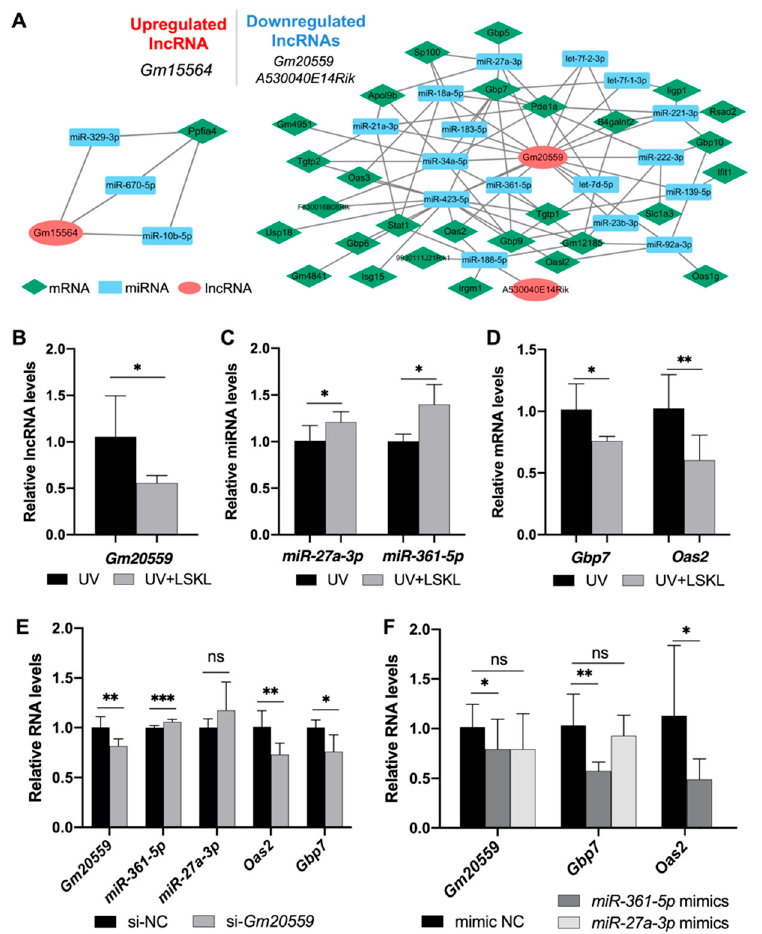
Figure 4. Construction and stepwise validation of a ceRNA network. ( A ) Up- and downregulated coexpression networks of DE-lncRNAs, DE-mRNAs and predicted target miRNAs. Red ovals, green triangles and blue rectangles represent lncRNAs, mRNAs, and miRNAs, respectively. The lines represent correlations. ( B ) RT ‒ qPCR analysis of Gm20559 in UV/Ctrl and UV/LSKL 661W cells. Gm20559 was downregulated in UV/LSKL 661W cells compared with UV/ctrl. ( C ) miR-27a-3p and miR-361-5p were upregulated in UV/LSKL 661W cells compared to UV/ctrl. ( D ) Oas2 and Gbp7 were downregulated in UV/LSKL 661W cells compared to UV/ctrl. ( E ) 661W cells were transfected with si- Gm20559 or si-NC for 48 h and exposed to UV radiation. The expression levels of Gm20559 , miR- 361-5p , miR-27a-3p , Oas2 and Gbp7 were then detected by RT ‒ qPCR. ( F ) 661W cells were transfected with miR-361-5p mimics, miR-27a-3p or NC mimics for 48 h and exposed to UV radiation. Afterward, the expression levels of Gm20559 , Oas2 and Gbp7 were detected by RT ‒ qPCR. Data are presented as the mean ± SD from 3 independent experiments. * p < 0.05, ** p < 0.01, ** * p < 0.001. Ns, no signifi-